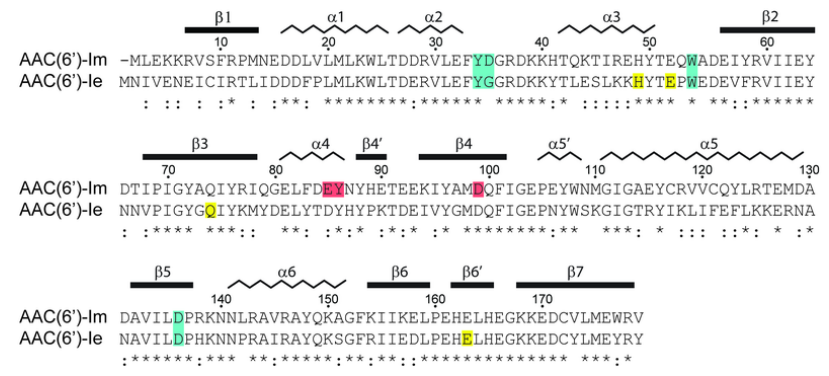
FIGURE 1: Sequence alignment of AAC(6’)-Im and AAC(6’)-Ie. The second- ary structure assignment for AAC(6’)-Im is shown above, and the identity (*) and similarity (:) is indicated below each block of sequence. Amino acids involved in kanamycin A binding are shaded blue for those which are common to both en- zymes, red for amino acids which interact with kanamycin A only in AAC(6’)-Im, and yellow for amino acids which interact with kanamycin A only in AAC(6’)-Ie [12]. The AAC(6’)-Im enzyme is one residue shorter than AAC(6’)-Ie, so for the sake of simplicity, the AAC(6’)-Im sequence num- bering begins at Met2 so that the se- quence numbering is the same for both